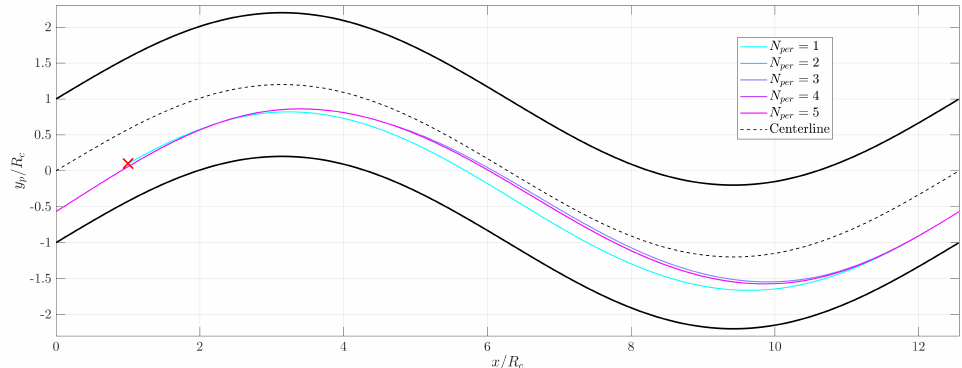
Figure 26. Trajectory of the particle in the xy plane, sequenced as periods (colored lines), case Re = 113. The red cross indicates the initial particle position, the bold black lines correspond to the pipe interface, and the dashed black line correspond to the centerline of the